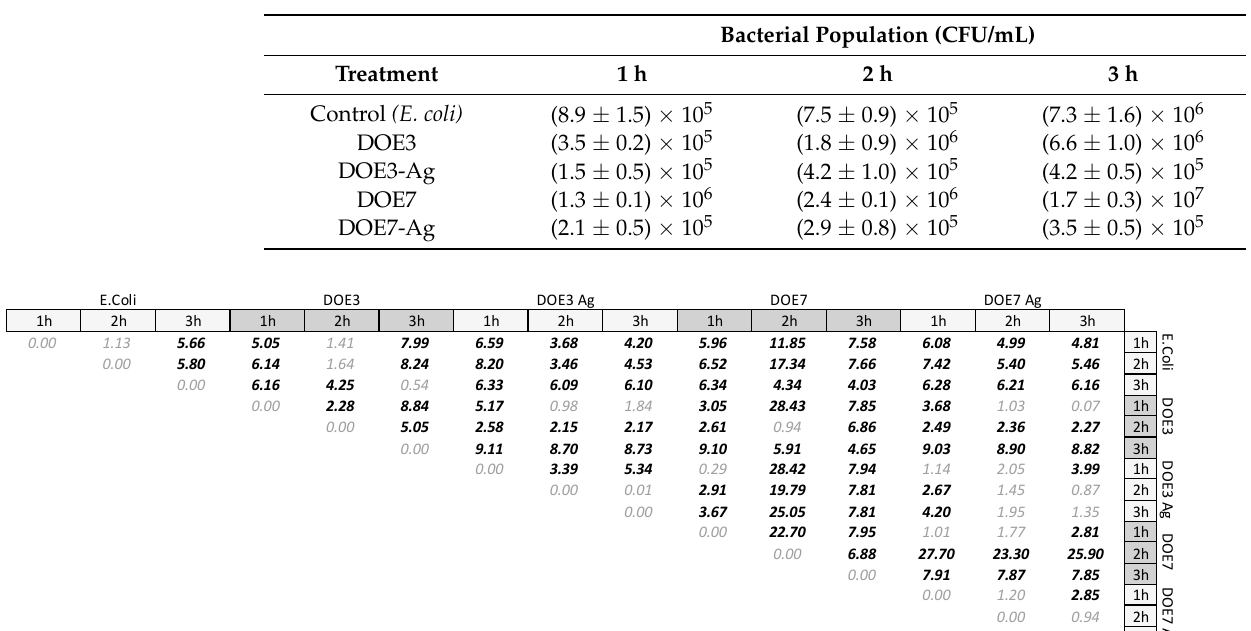
Figure 13. Plot of mean value of each treatment vs. grand mean of all pooled data. Following method 2 described in Section 2.9, the bacterial population normalized with respect to the E. coli control culture is reported in Figure 14 (left panel), where the inhibitory effect in the coated samples is evident in comparison with the microbial growth on the uncoated PSU samples. The antimicrobial effect of the Ag nanocoating is more clear when calculating the residual bacterial population on the Ag-coated samples as a percent- age with respect to the corresponding uncoated substrates, as demonstrated in Figure 14 (right panel). Figure 14. Left panel: Bacterial population on uncoated (black points) and coated (red points) sam- ples normalized with respect to the E. coli control culture as a function of time. Right panel: